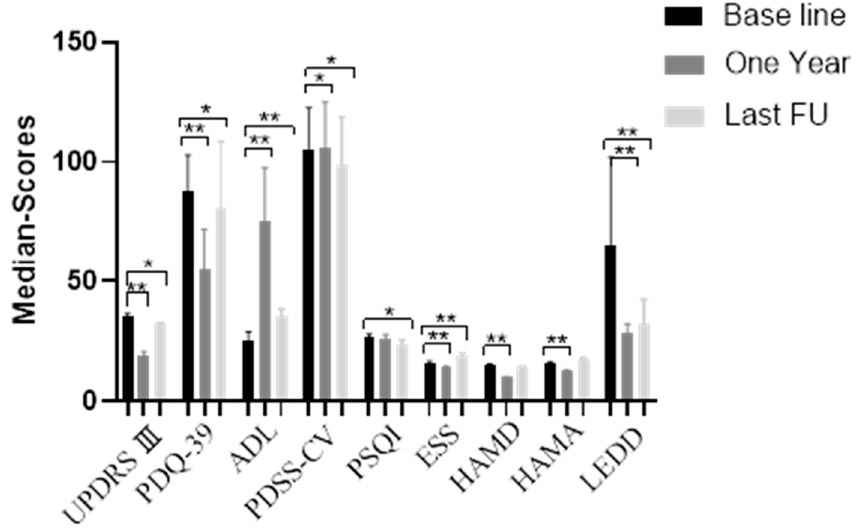
Figure 1. Visual analysis of histograms. * p < 0.05; ** p < 0.01. Table 2. UPDRS-III, PDQ-39, and ADL-Barthel Index scores at baseline, 1 year post operation, and